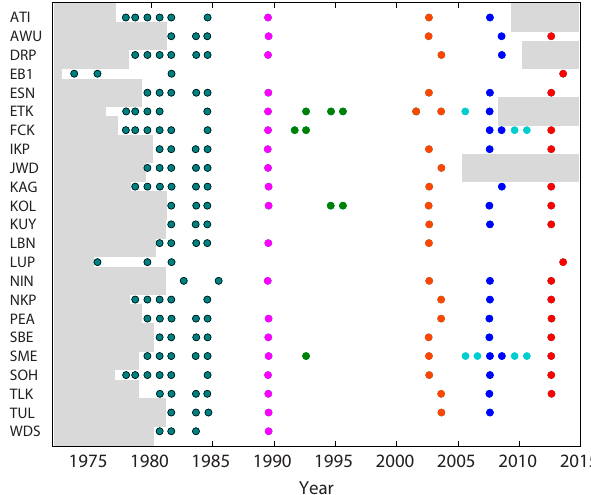
Figure 2. Temperature logging history for the DOI/GTN-P Deep Borehole Array. Major field campaigns occurred during 1977–1984 (teal), 1989 (magenta), 2002–2003 (orange-red), 2007–2008 (blue), and 2012–2013 (red). Gray areas indicate times before well com- pletion, and in some instances when the wells have been plugged and abandoned due to coastal erosion